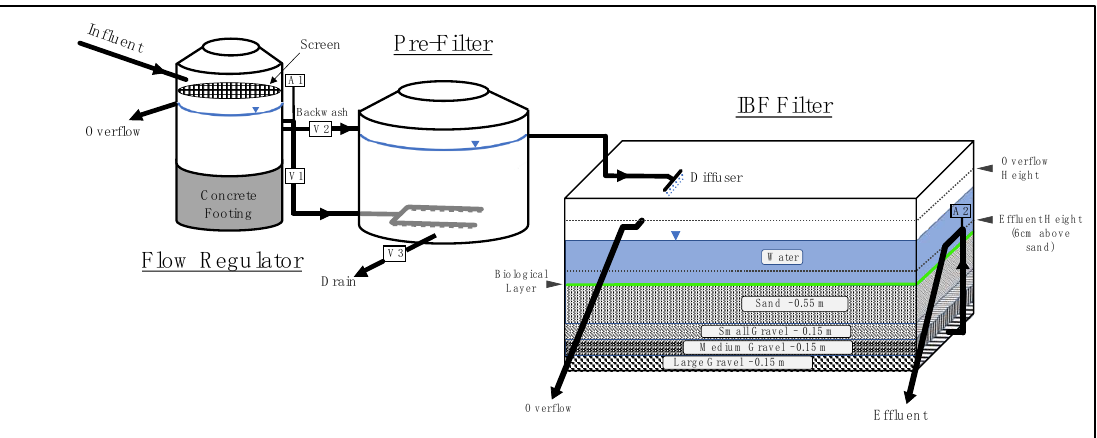
Figure 2. The induced bank filtration (IBF) treatment system consists of a flow regulator tank, ascending flow gravel pre-filter and descending flow IBF filter. During normal operation, valve V1 is open and valves V2 and V3 remain fully closed. A1 and A2 represent airlocks. Influent water samples were collected before the flow regulating tank. Effluent samples were collected after the IBF filter. Drawn not to scale.